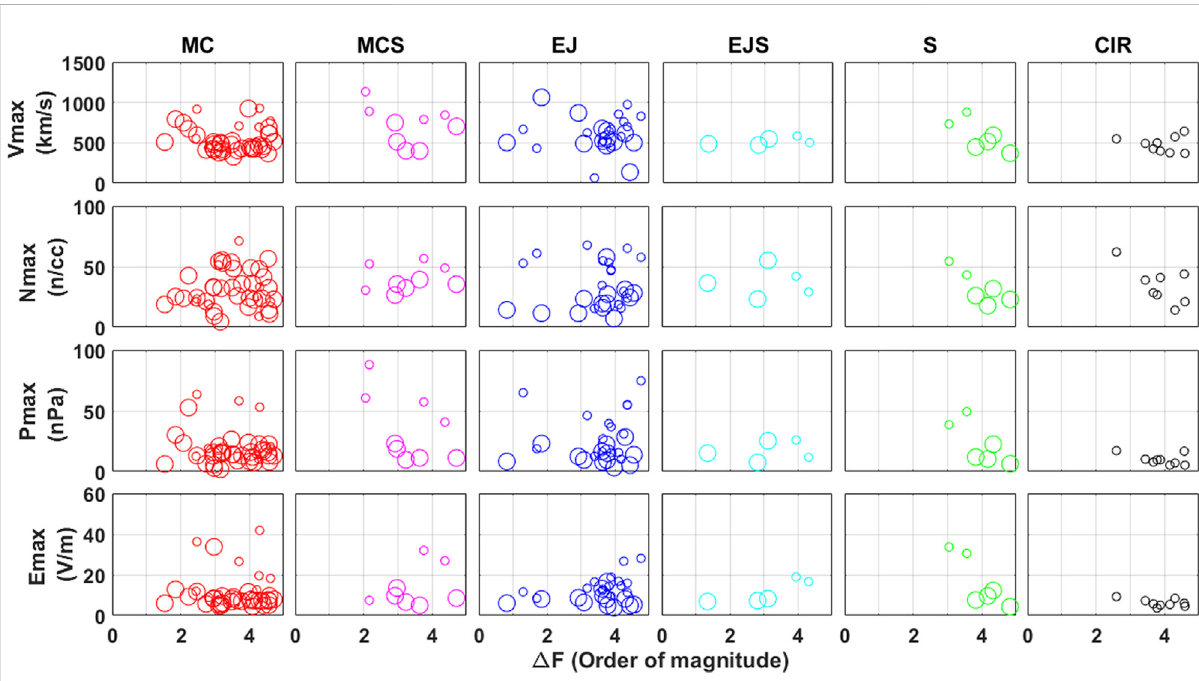
FIGURE 5 Variation of decrease in the electron fl ux ( Δ F in orders of magnitude) with maximum solar wind speed (Vmax in km/s), density (Nmax in n/cc), pressure (Pmax innPa), and electric fi eld (Emax inV/m) for differentsolar drivers. Superimposed on that is theIMF Bz in two groups:IMF Bz > − 20 nT (small circles) and IMF Bz < − 20 nT (big